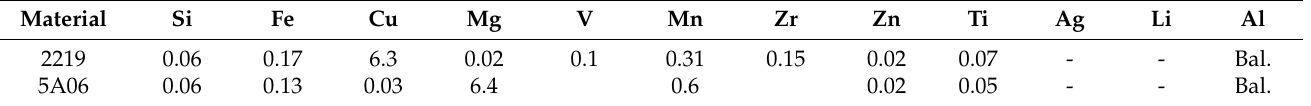
Table 1. Chemical composition of 2219 and